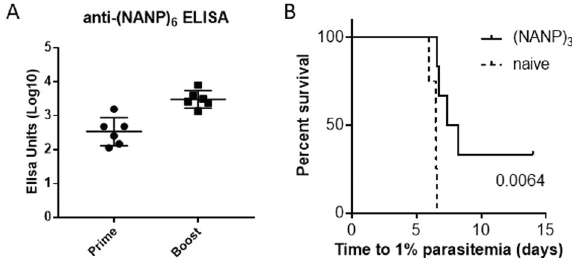
Fig. 1 Immunogenicity and protective ef fi cacy of a Q β -(NANP) 3 vaccine. BALB/c mice ( n = 6) per group were vaccinated by intramuscular injection (20 µg per dose, two shots, 3-week prime- boost interval) with (NANP) 3 chemically coupled to Q β virus-like particle and delivered with Matrix-M ™ adjuvant. A Standard curve ELISAs performed to determine the antibody response against (NANP) 6 peptide. Means are shown ± SD. B Mice were challenged by intravenous injection of 1000 PfCSP-replacement P. berghei spor- ozoites. The time to reach 1% blood-stage parasitaemia was calculated by linear regression from daily thin blood smears. P values from Log-rank tests in comparison to naïves are